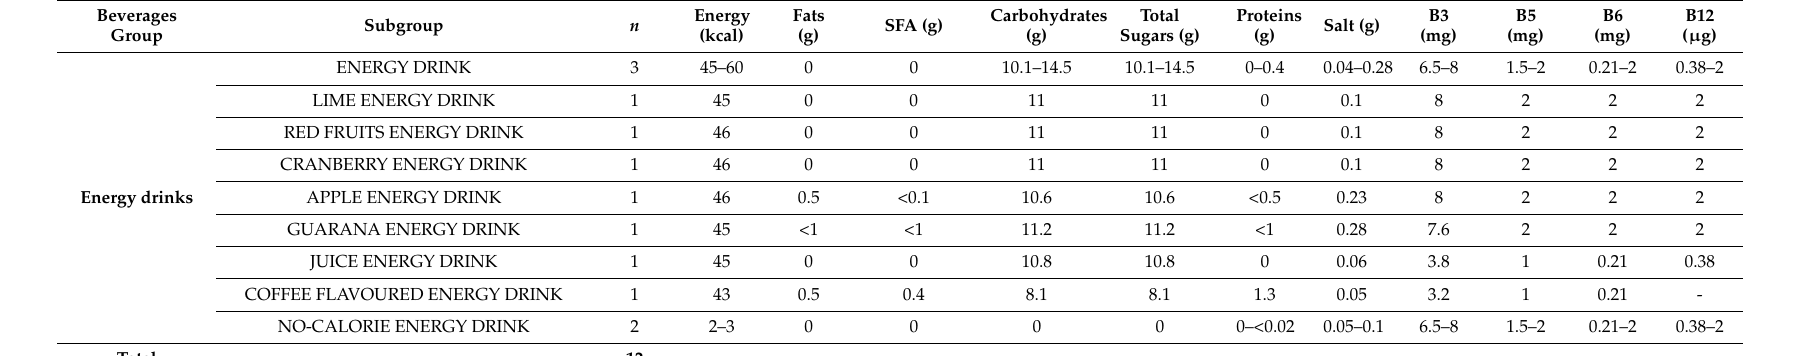
Table 3. Nutrition facts from the “energy drinks” group in the Spanish food market.